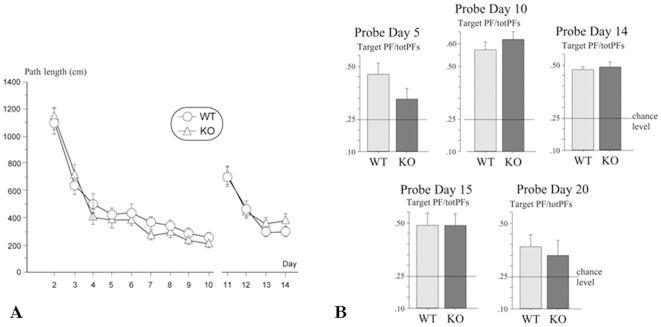
Spatial learning and reference memory of the 5-HTR4 knock-out mice (experiment 1).Left-hand side (A): Performance over days (2–14) for the acquisition (days 2–10) and the reversal (days 11–14) of spatial memory testing in the Morris water maze for wild-type (WT) and 5-HTR4 knock-out (KO) mice. The score on each day represents the mean ± s.e. of path length (cm). Right-hand side (B): Probe trials (60 s) on days 5, 10, 14, 15, and 20. Mean ± s.e. path length in the target platform zone/sum of path lengths in the four equivalent zones (target PF/totPFs) in WT and KO mice. Horizontal lines represent chance level.